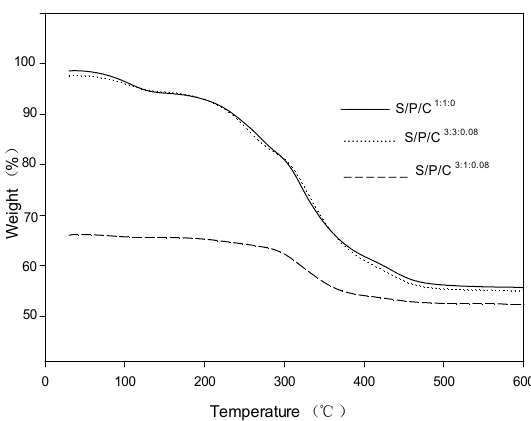
Figure 3. TGA thermograms of starch/polyvinyl alcohol/citric acid ternary blend functional food packaging films.